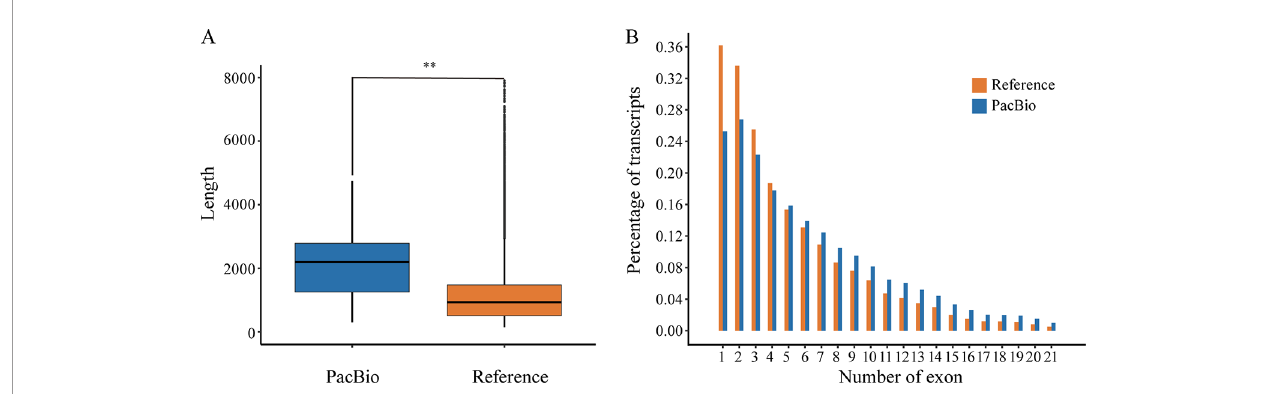
FIGURE 1 | The comparison between reference annotation and PacBio Iso-Seq data. (A) Box-plots show distribution patterns of transcript length (Wilcoxon rank sum test:**, P < 0.001). (B) Distribution of exon number